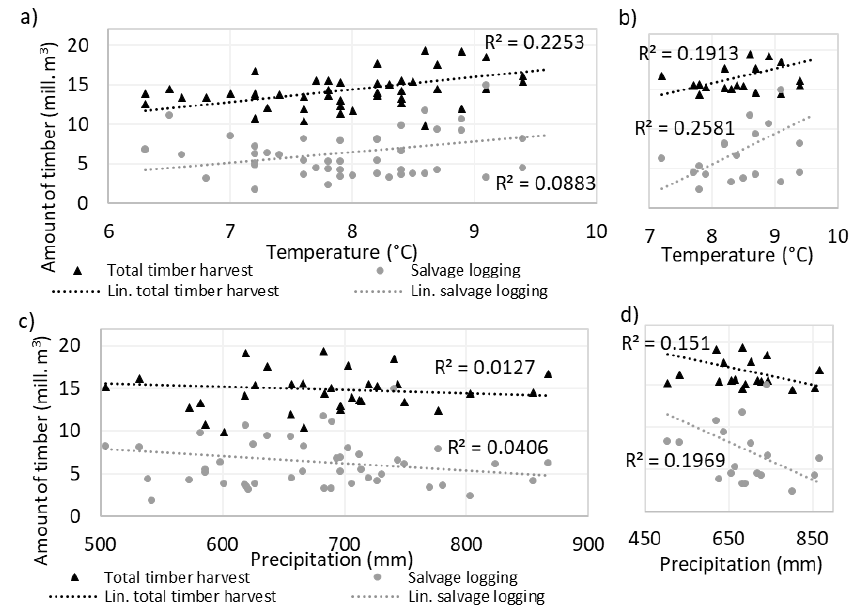
Figure 5. Scatter plot; average annual air temperatures in relation to salvage logging and total